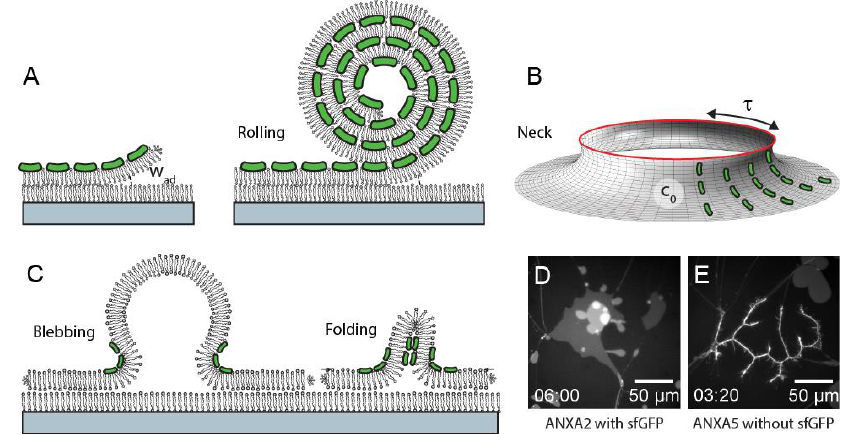
Figure 1. Binding of annexins (green) to a planar membrane patch with free edges and adhesion energy w ad inducing spontaneous curvature and a rolling morphology of the patch ( A ). Translation to the geometry of a membrane hole ( B ) where the edge tension τ and the spontaneous curvature c 0 acts to create a stable neck conformation. Example of blebbing/folding morphologies induced by ANXA1 and ANXA2 ( C ) and examples of fluorescence data for patches (POPC: 1-palmitoyl-2-oleoyl-sn-glycero-3-phosphocholine, POPS: (1-palmitoyl-2-oleoyl-sn-glycero-3-phospho-L-serine), 9:1 ratio, DiDC18) showing blebbing ( D ) and rolling ( E ).